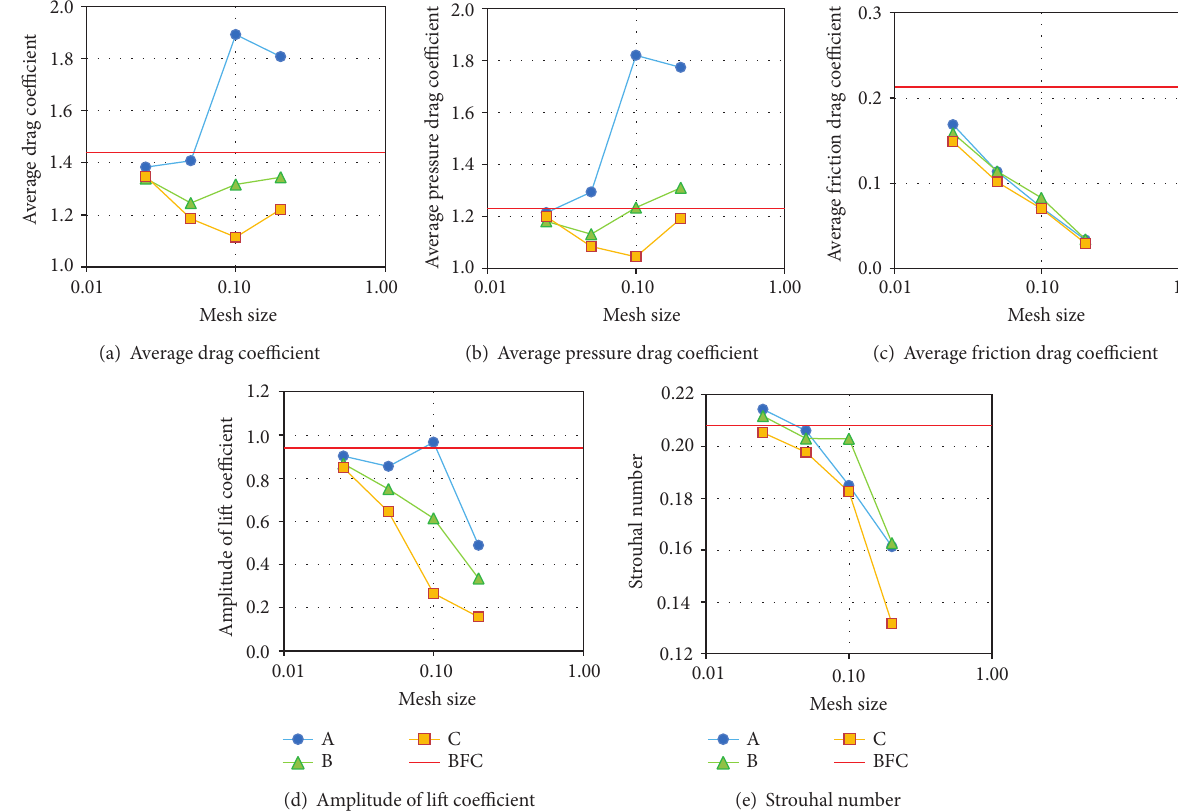
Figure 11: Effect of mesh size on aerodynamic coefficients at Mach 0.3. The red lines are reference